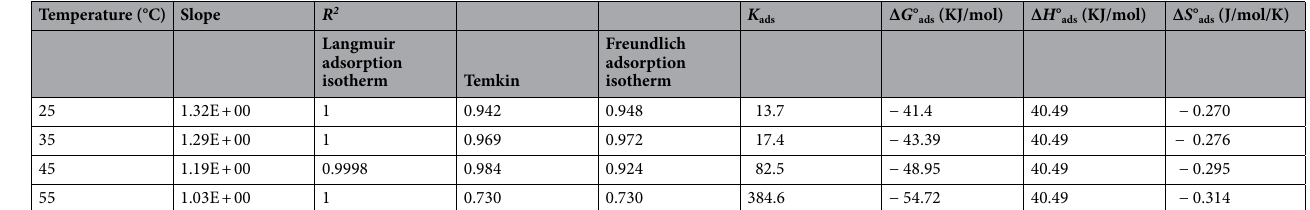
Table 2. Thermodynamic characteristics of adsorption for MS in 5% HCl at different temperatures.